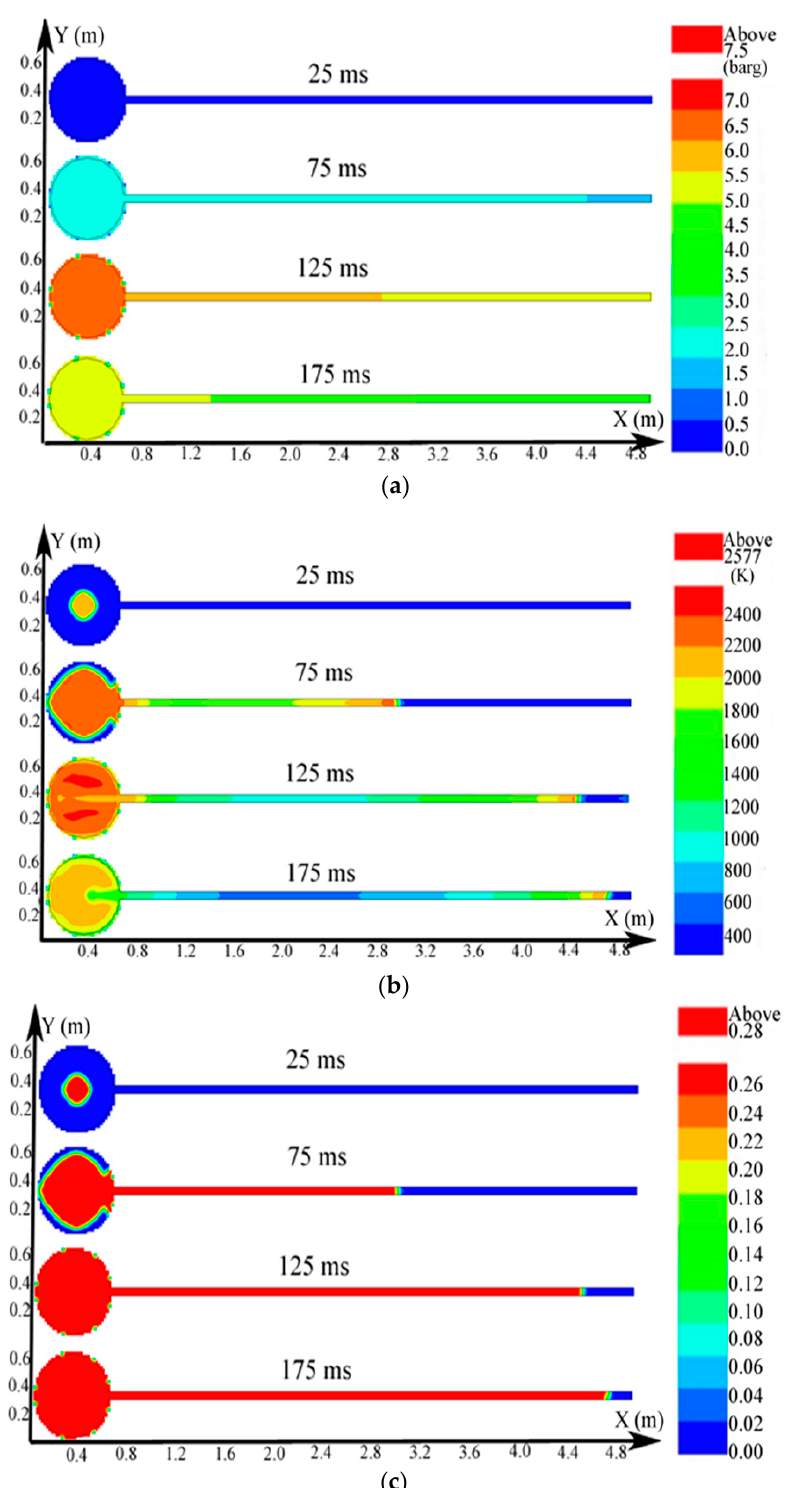
Figure 6. Contours of the natural gas explosion parameters (pressure, temperature, and concentration of products) in the single vessel with a pipe connected to it; ( a ) distribution of pressure. ( b ) distribution of temperature; ( c ) distribution of the concentration of products.